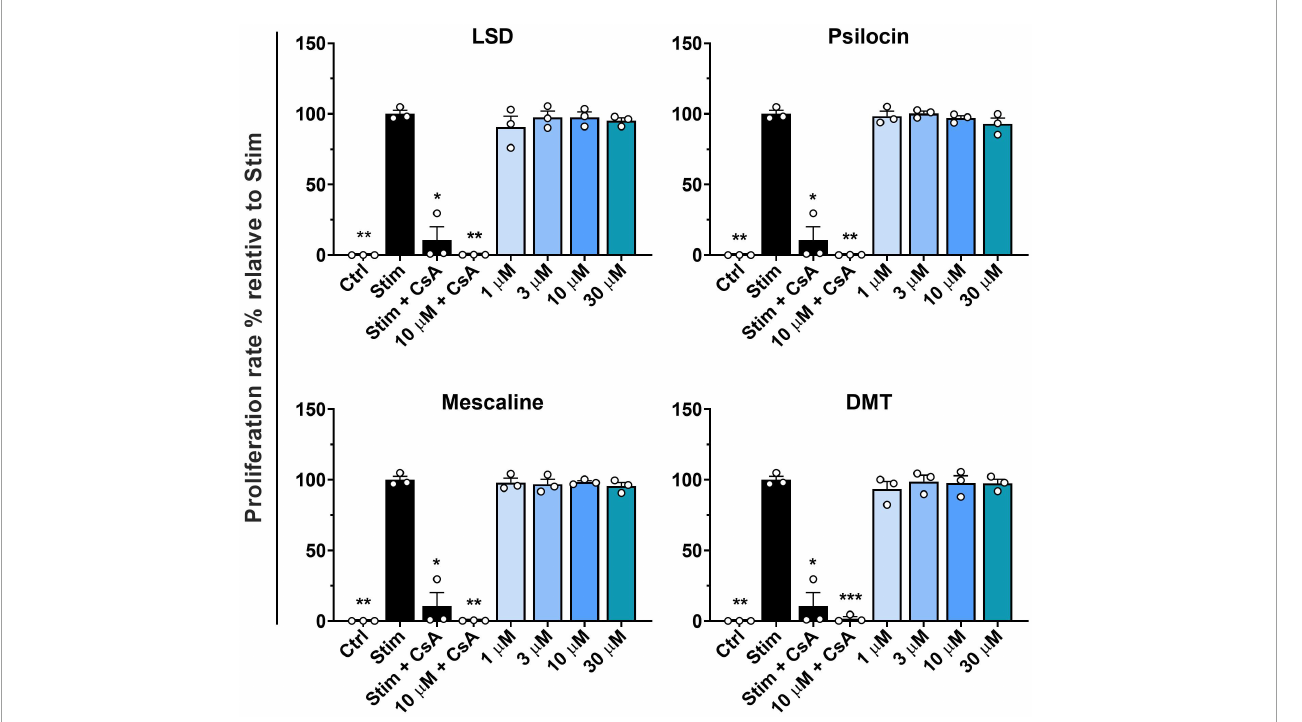
FIGURE1 Influence of classic psychedelics on the proliferation of primary human T lymphocytes. PBMCs were stimulated with anti-human CD3 and anti-human CD28 mAb (Stim) and incubated in the presence of medium alone (Neg Ctrl), different control substances, and psychedelic compounds for 72 h. Cyclosporine A (CsA) served as a control substance for proliferation inhibition. Data are the mean ± SD from three independent experiments. Data were analyzed by one-way ANOVA followed by Dunnett’s T3 multiple comparison test (*** P < 0.001, ** P < 0.01, * P < 0.05 when compared to stimulated cells without drug treatment).